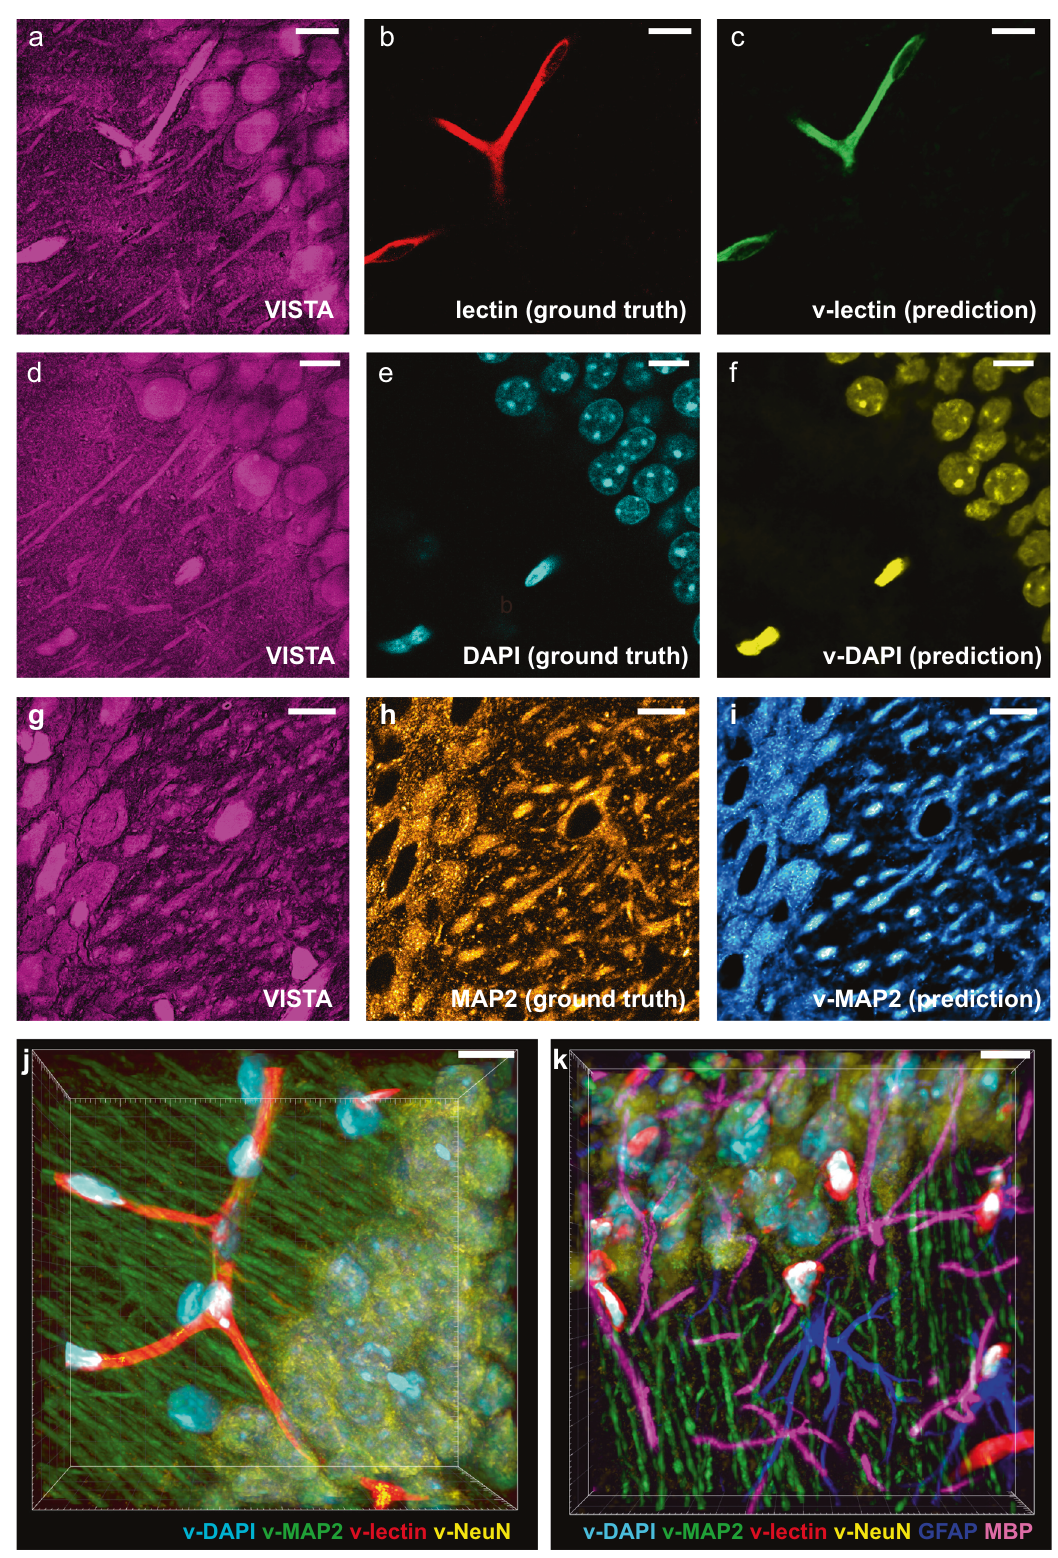
machine learning algorithm based on new training tailored for the void chromosomal regions, in combination with mitotic cell markers. With all these features, VISTA should fi nd a wide range of applications for mapping subcellular architectures, cell dis- tributions, and connectivity across various molecular and reso- lution scales in complex